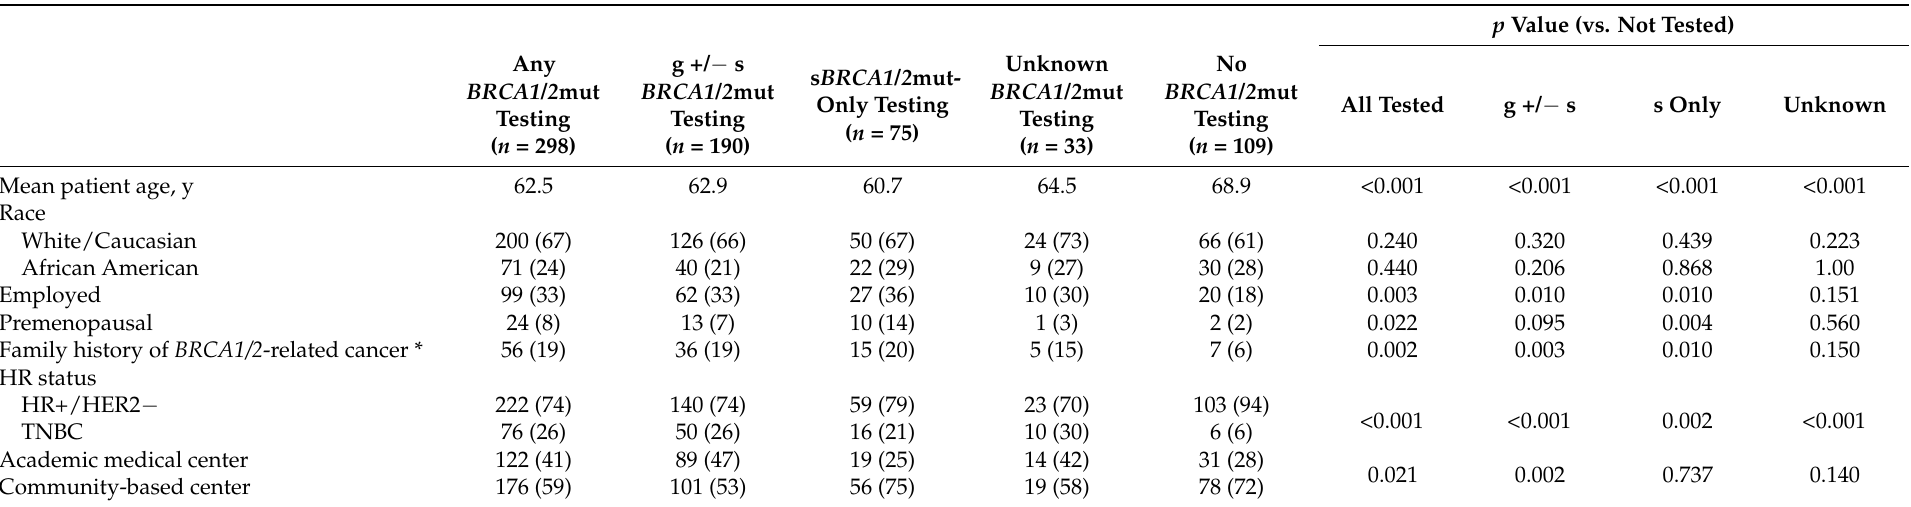
Table 1. Patient demographics and clinical characteristics by BRCA1/2 mut testing status among patients with HER2—ABC in the United States.